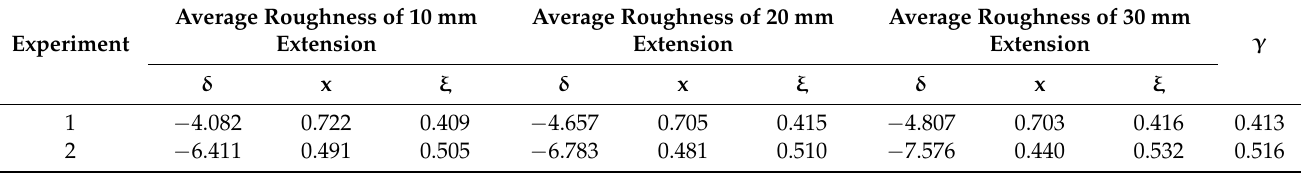
Table 3. Grey correlation analysis